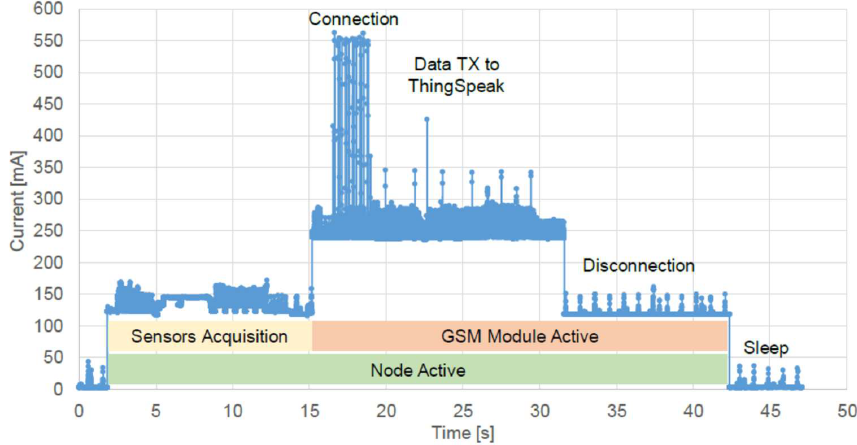
Figure 11. Recording of the node current consumption during an operation cycle.